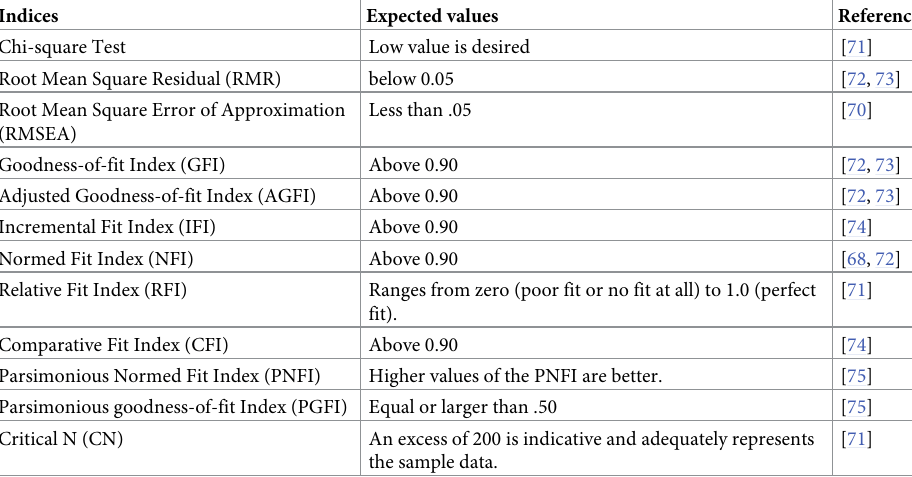
Table 2. The overall model fit indices of